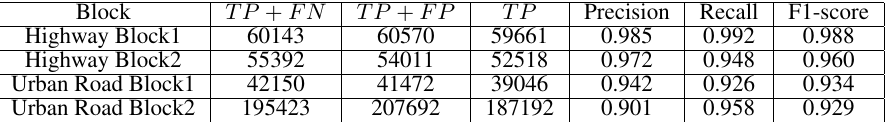
Table 1. Road marking point cloud extraction